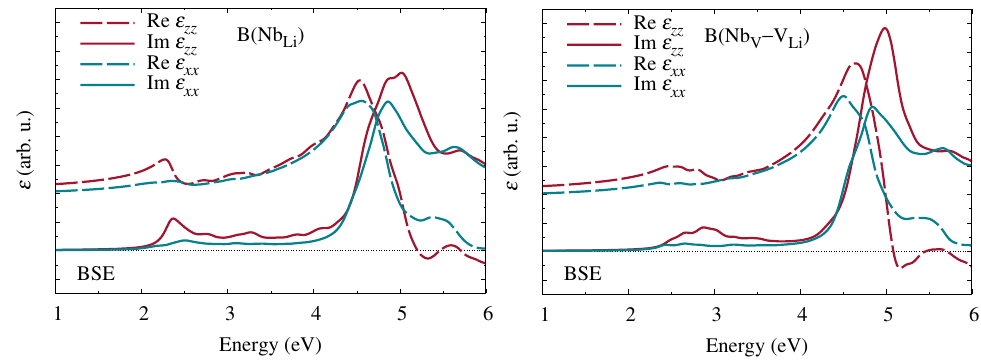
Figure 7. Imaginary (solid lines) and real (dashed lines) parts of the dielectric function ε calculated within the BSE for z -polarized (red) and x -polarized (blue) light. The left and right panel correspond to bipolarons at a Nb Li antisite defect and a Nb V –V Li defect pair, respectively. From the complex dielectric function calculated within the BSE, we can finally derive other optical coefficients that are typically measured in experimental spectroscopies, such as the reflectivity R ( ω ) , the absorption (attenuation) coefficient α ( ω ) , and the electron- energy-loss function L ( ω ) . Our results for the z (red) and x (blue) components are shown in Figure 8. The left panels again refer to bipolarons at the antisite defect, the right panels to bipolarons at the defect pair. As for the dielectric function itself, the polaron signatures are much more pronounced in the z components but are clearly present in all optical coefficients. The calculated absorption coefficients are further compared to the experimental value of 2.5 eV that is frequently cited in the literature, for example in [13], as well as a recent measurement by our co-workers [12] that yielded 2.7 eV. Both values were obtained from the peak position in the absorption spectrum of congruent LN, measured in the z direction. Although the two experimental values deviate slightly, indicating variations due to sample preparation and/or measurement technique, both lie between the calculated defect-related absorption maxima for the Nb Li antisite defect and the Nb V –V Li defect pair. This may indicate that at least some of the antisite niobium atoms indeed migrate to neighboring oxygen octahedra, creating interstitial-vacancy pairs that modify the lineshape and apparent position of the bipolaron absorption